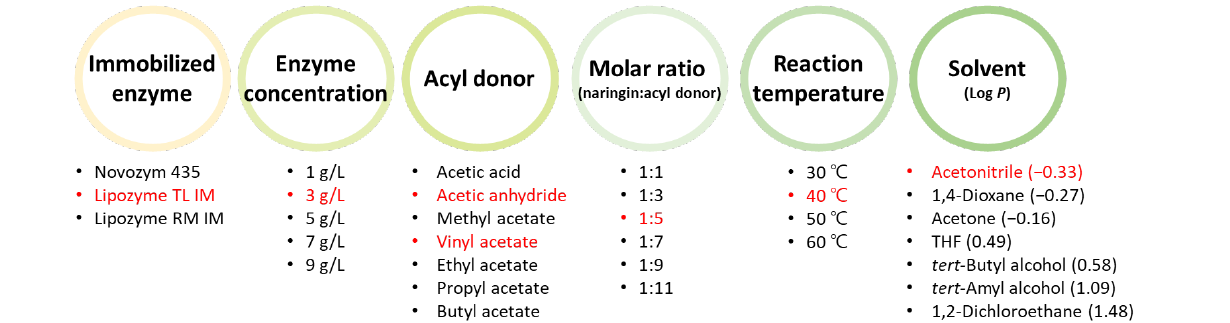
Figure 2. Optimization procedure to produce naringin acetate using naringin and acyl donors. (Red highlighted points: determined variables for the synthesis of naringin acetate).